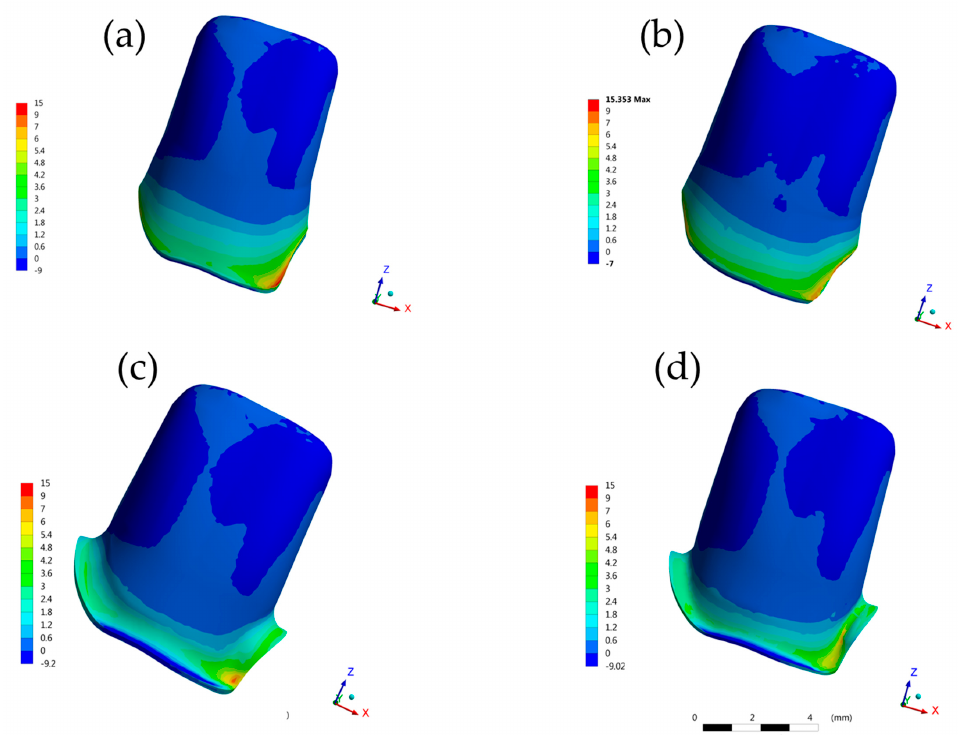
Figure 4. Buccal view of contour plots of each restorative procedure First principal stress (MPa) in the crown cement layer. ( a ) BOPTB, ( b ) BOPT, ( c ) CM and ( d ) SM.